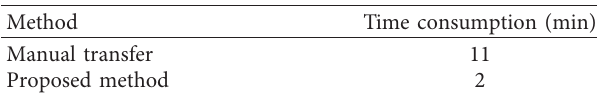
Table 4: Performance comparison of the proposed method with manual